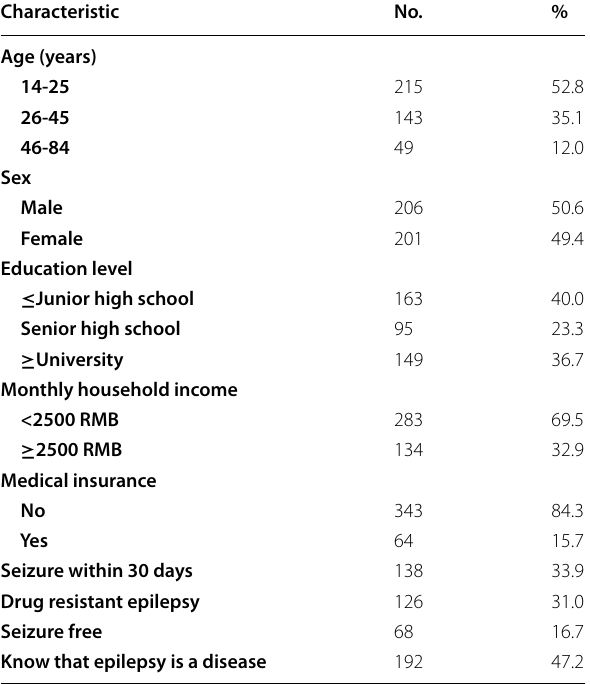
Table 1 Characteristics of patients with epilepsy Characteristic